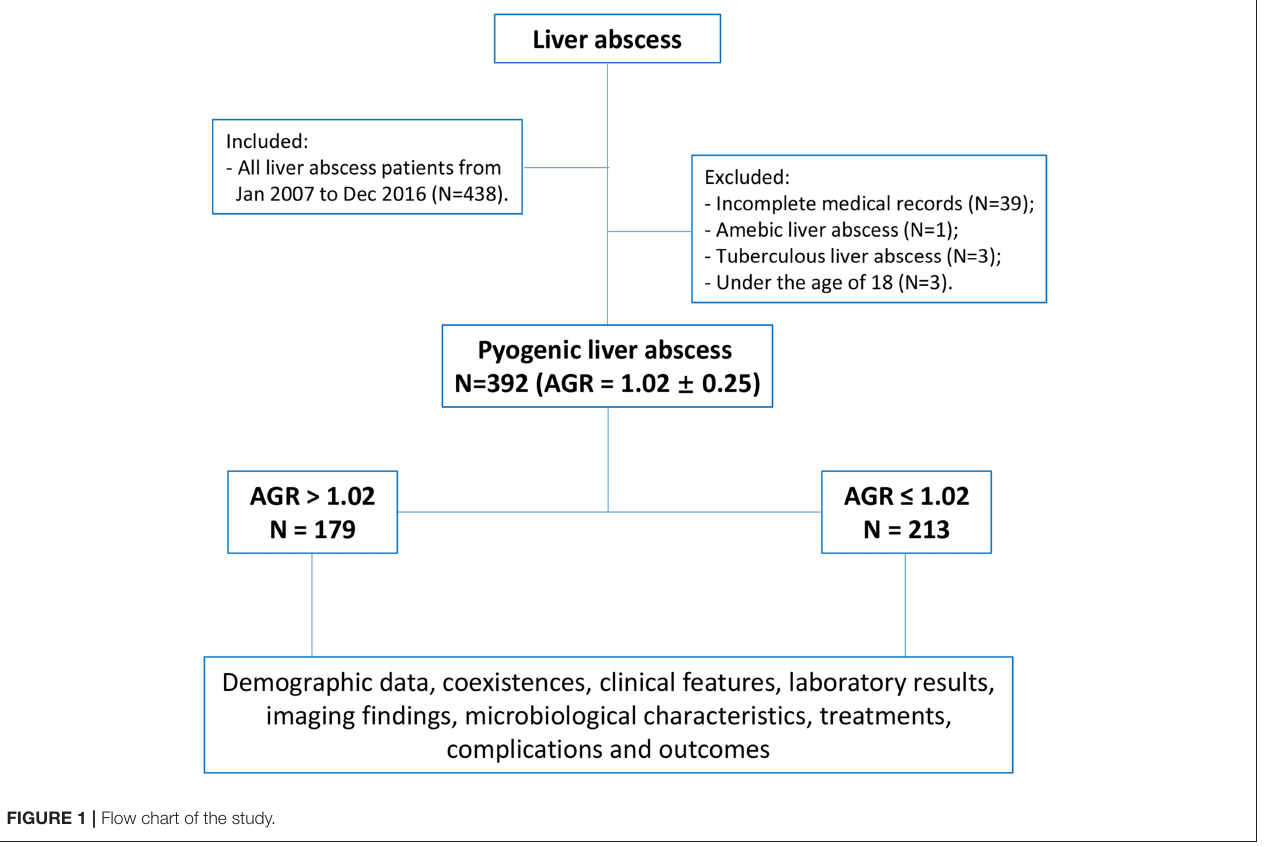
FIGURE 1 | Flow chart of the study.